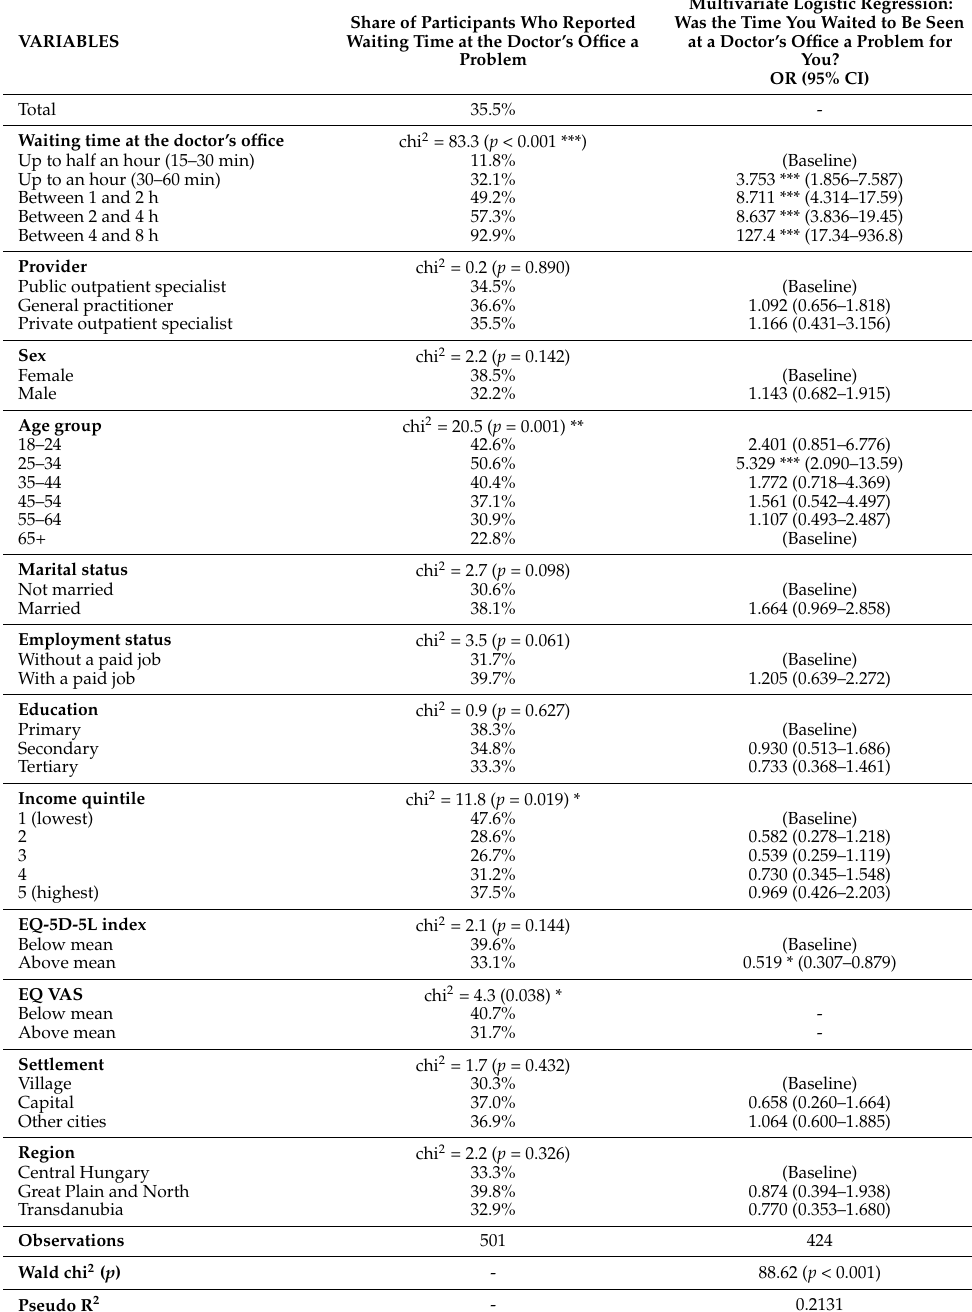
Table 7. Waiting time at the doctor’s office perceived as a problem: share of participants by covariates and multivariate logistic regression